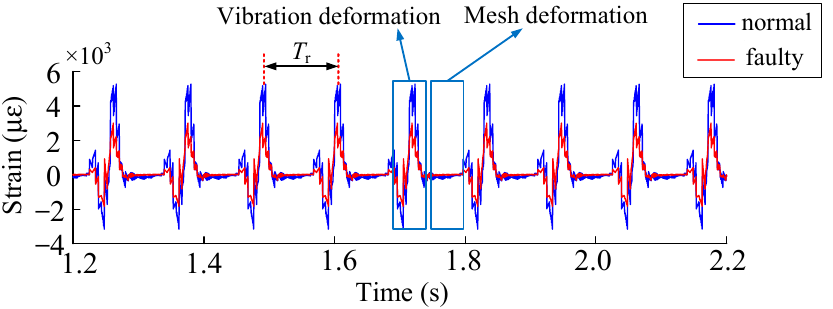
Figure 19. Time-domain history diagram of the strain signal of the inner ring tooth root crack.